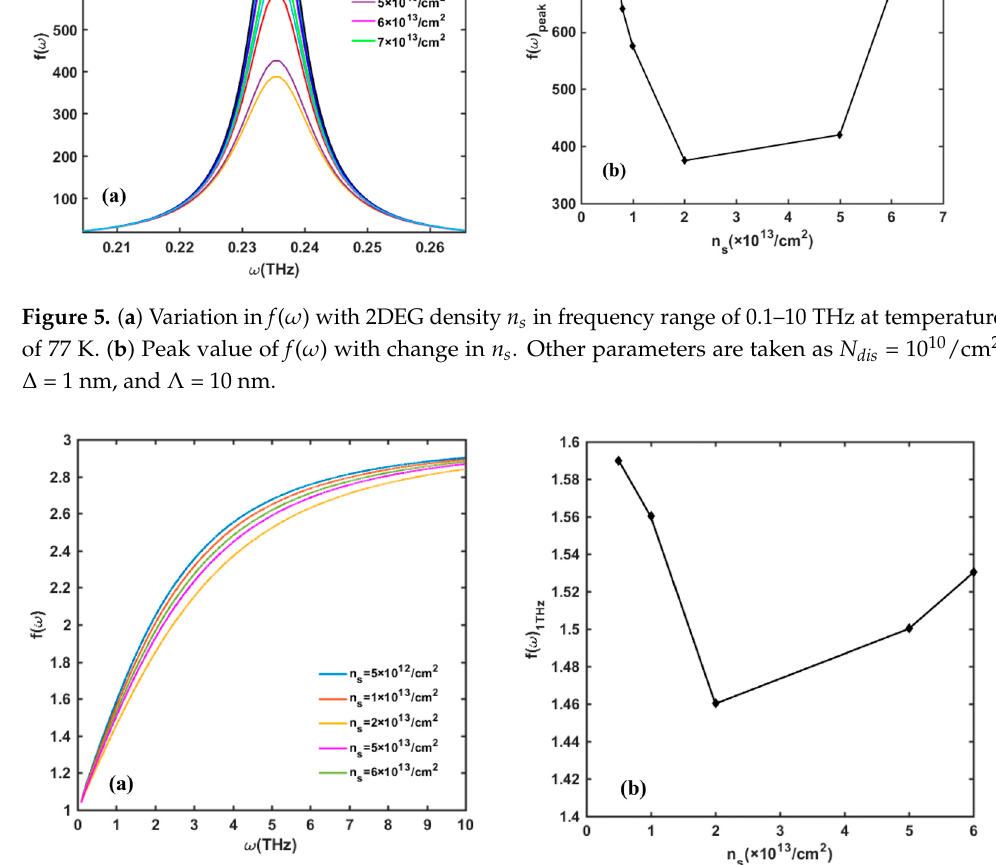
Figure 6. ( a ) Variation in f ( ω ) with 2DEG density n s in frequency range of 0.1–10 THz at temperature of 300 K. ( b ) Value of f ( ω ) at 1 THz incident frequency with change in n s . Other parameters are taken as N dis = 10 10 /cm 2 , ∆ = 1 nm, and Λ = 10